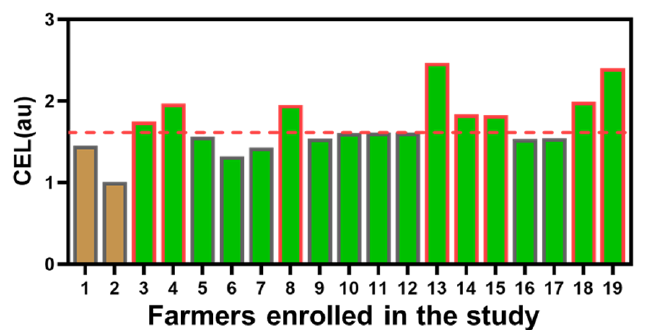
Figure 2. Chronic exposure levels (CELs) in MNZ-exposed workers. Numbers from 1 to 19 in the x axis univocally identify each subject enrolled in the study. Brown bars indicate CEL values calculated for spreading workers, green bars indicate CEL values calculated for seedling workers. Red dotted line at 1.61 au indicates the cut-off median value. Bars with red borders indicate samples with CEL au values above the cut-off limit.